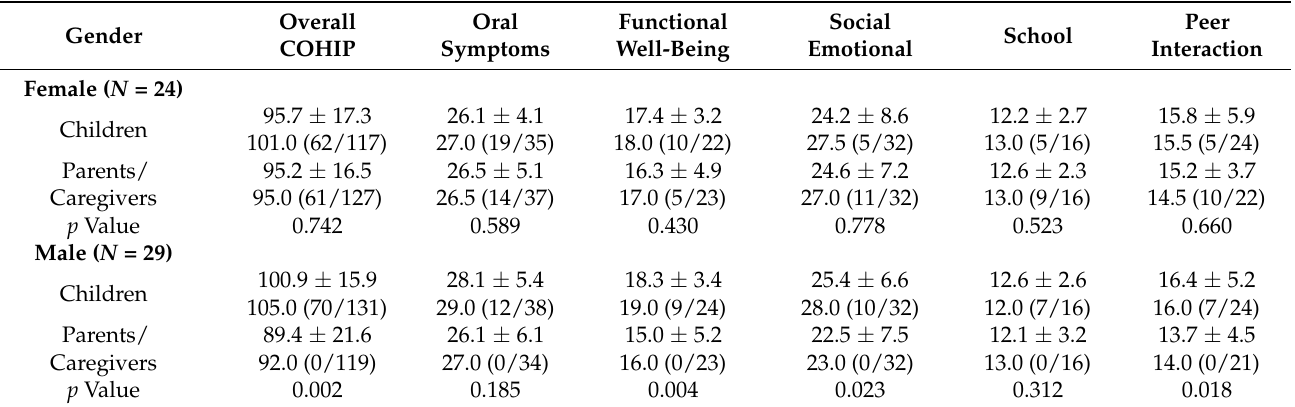
Table 4. Effect of children’s gender on the agreement in COHIP overall and subscale scores between parents and children with cleft [mean ± SD, median, (range)].